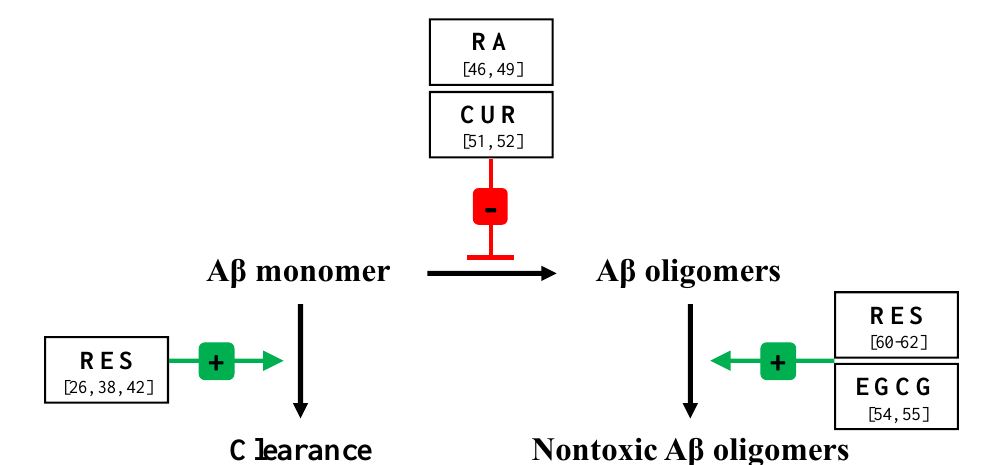
Figure 4. Modulation of the formation of toxic A β oligomers by polyphenols. Resveratrol enhances the clearance of A β monomer. Rosmarinic acid and curcumin directly inhibit oligomerization by interfering with peptide–peptide interactions while resveratrol and EGCG remodel toxic A β oligomers to nontoxic assemblies.